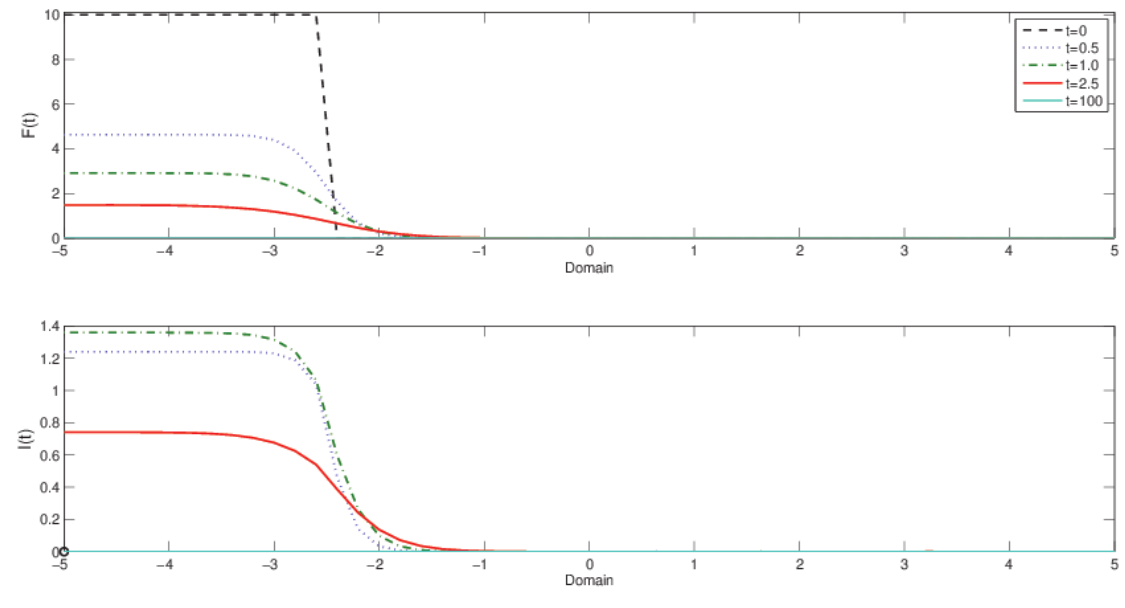
Fig. 8. The time evolution of pathogen and disease through the field at different times, using the parameter values that satisfy the conditions for stability of the PFE that were obtained by the application of LaSalle’s Invariance Principle.